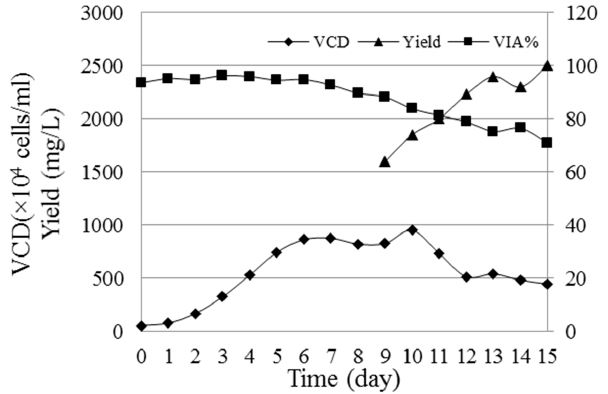
Figure 1. The viability (VIA%), viable cell density (VCD) and yield of HM-3-Fc cells cultured for 15 days. Sterilely taken cells from bioreactor were stained by 0.4% trypan blue and then counted with a Countstar IC-1000 cell counter. The results of viable cells are summarized; VIA% = number of viable cells/total cell number × 100%. The protein expression amount was detected by size exclusion chromatography-high pressure liquid chromatography (SEC-HPLC)